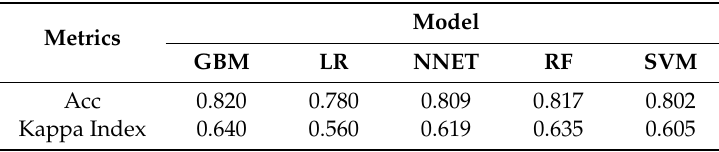
Table 8. The overall performances of the trained landslide